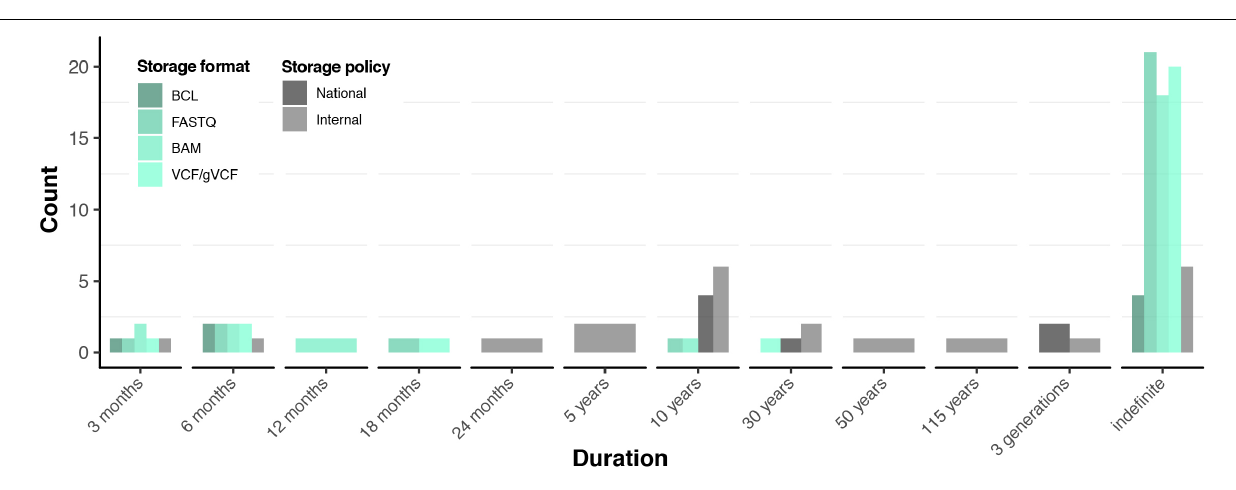
FIGURE 3 | Data retention practices and policies. Green scale represents storage practices in terms of stored file formats. Grey scale represents national and internal institutional data storage policies reported by the respondents. Detailed information available in Supplementary File 2: Table S5